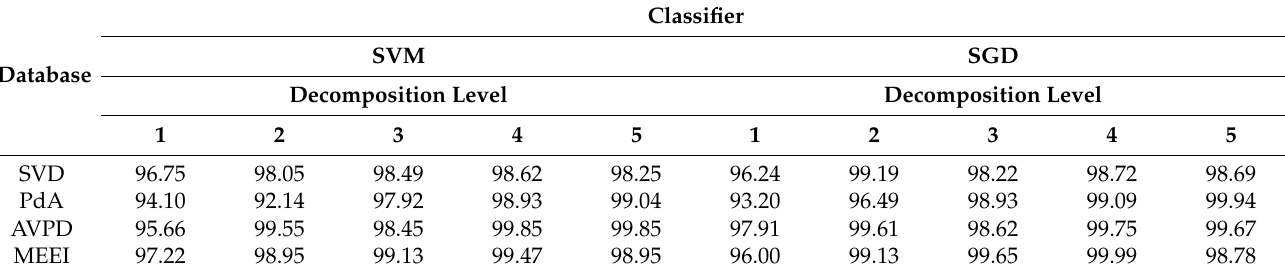
Table 16. Decomposition level effect on classifying rate (%).